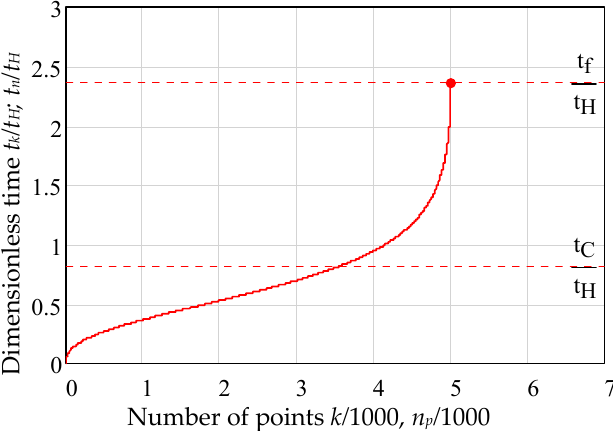
Figure 12. Dependence of times on the order number of the points.